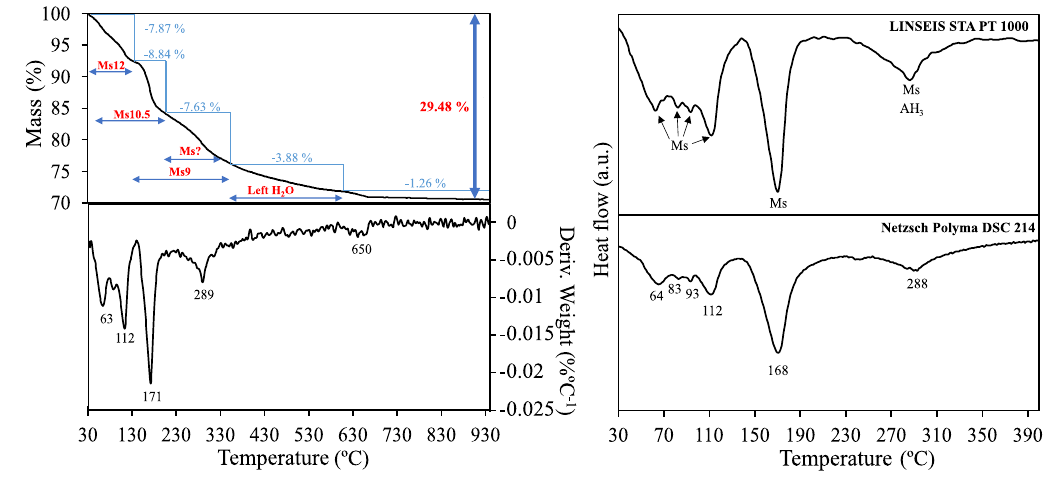
Figure 8. TG, DTG and DSC curves of the sample after hydrothermal